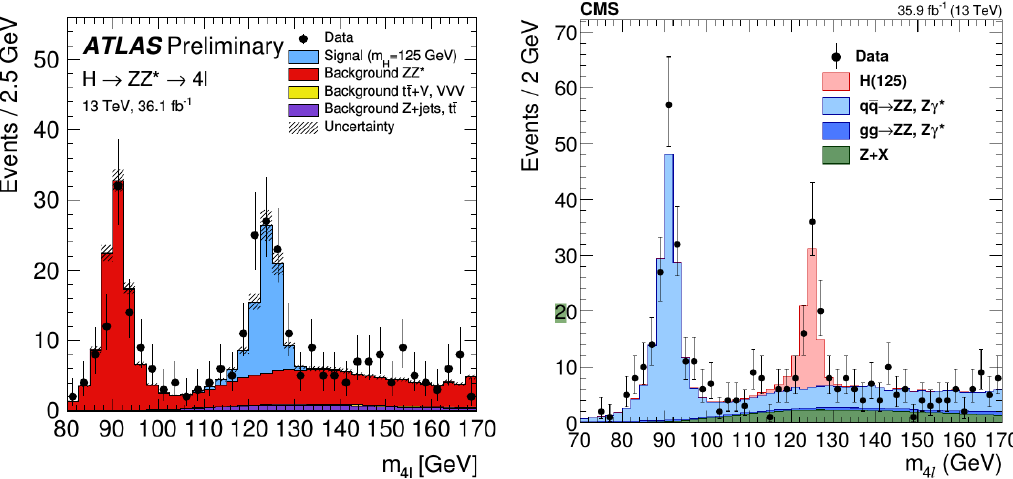
Figure 6. New measurements of the mass of the Higgs boson by the ATLAS [13] and CMS [14] Collaborations at the LHC at 13TeV p-p collision energy using the H → 4 (cid:96) ( (cid:96) = e ± , µ ± ) decay channel.